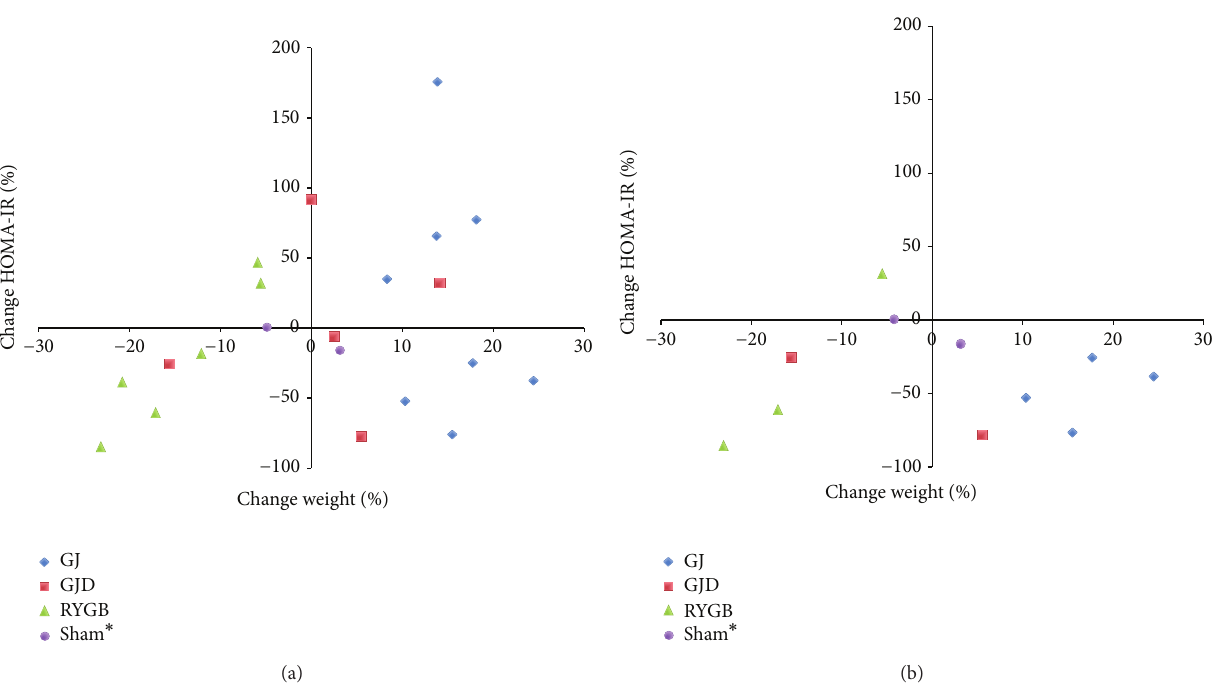
/AUC for RYGB, GJ, GJD, and Sham procedures. “ ∗ indicates” insulin glucose